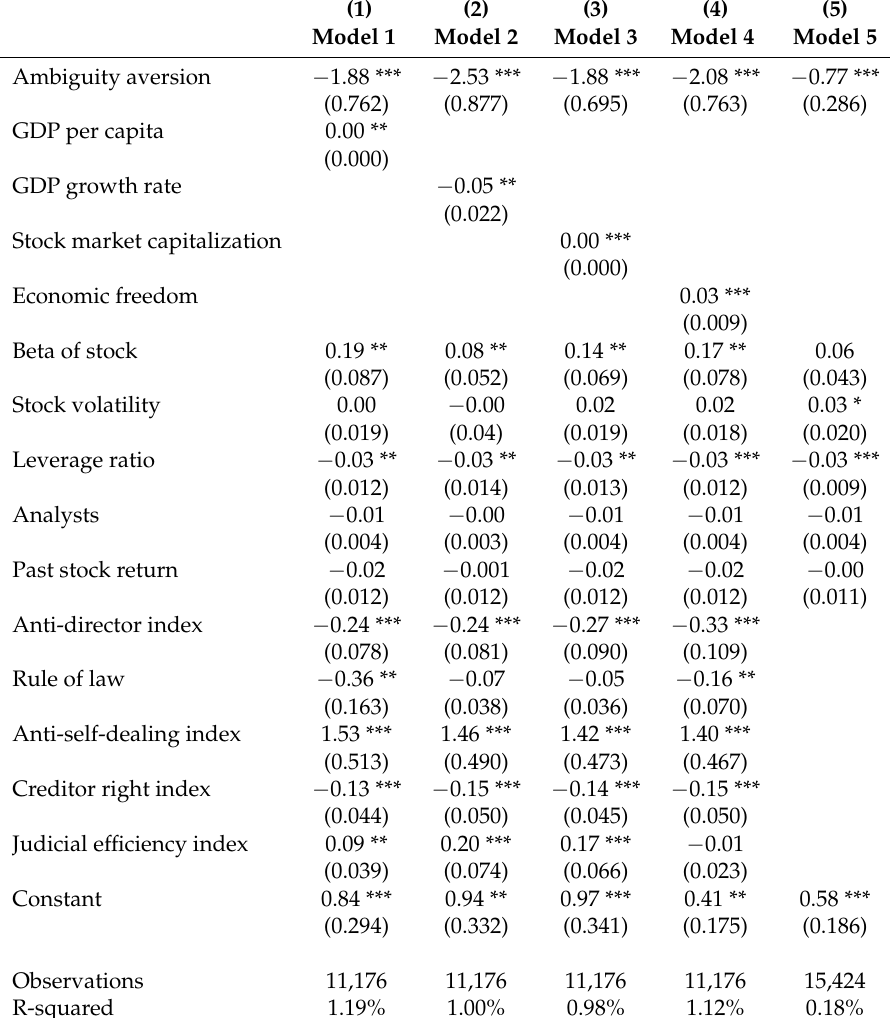
Table 4. Regression results for the equity premium and ambiguity